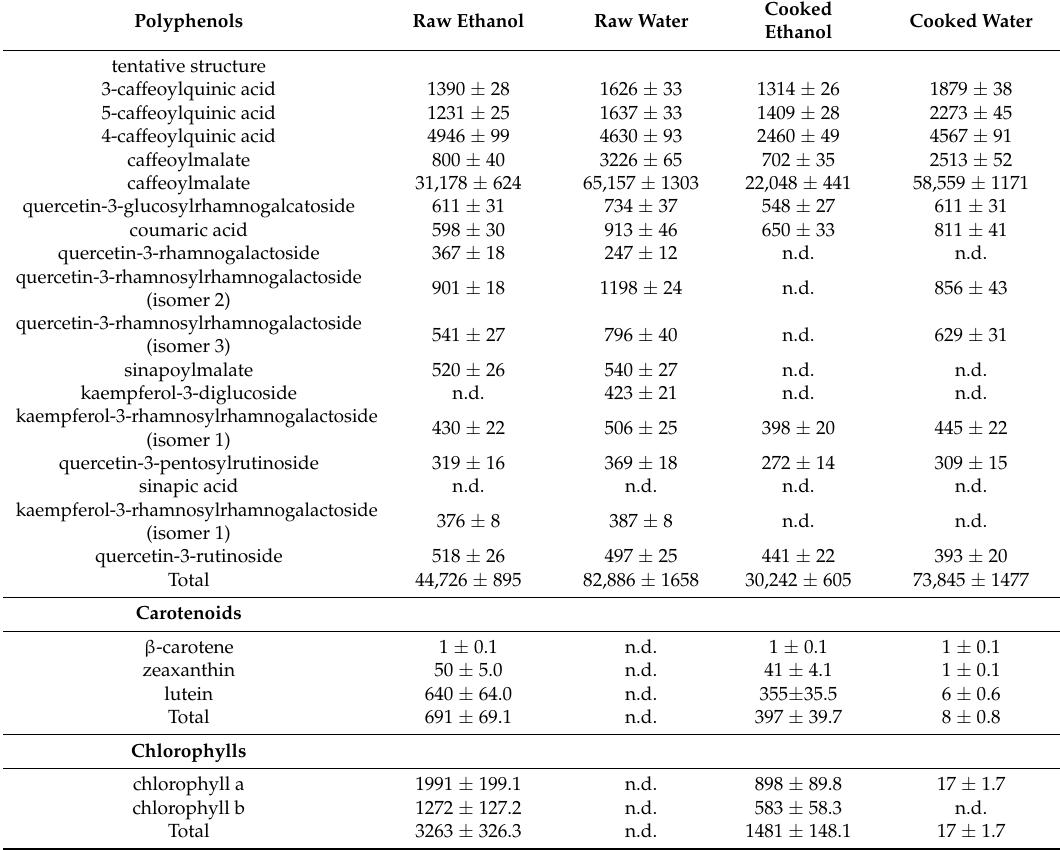
Table 2. Phytochemical content in the extracts of raw vs. cooked S. scabrum in µ g/g DM (location B). The data are presented as phytochemical content ± average analytical